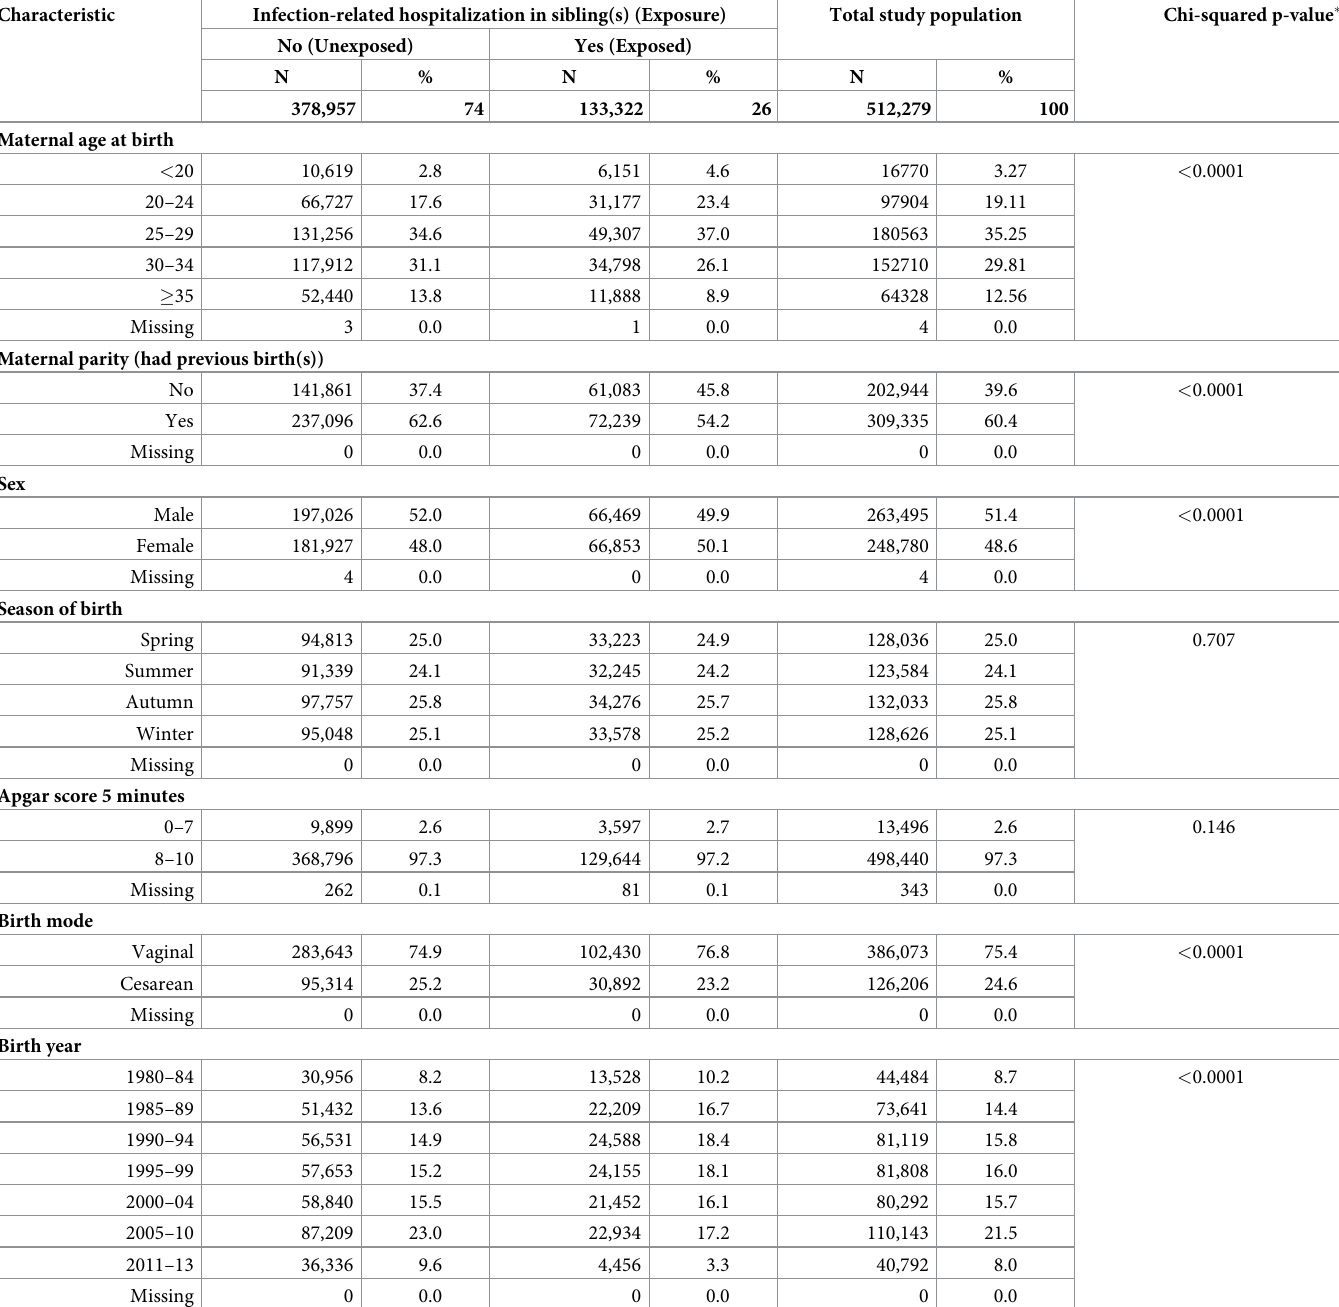
Table 1. Characteristics of proband children in study population, time-varying exposure status at end of follow-up period.